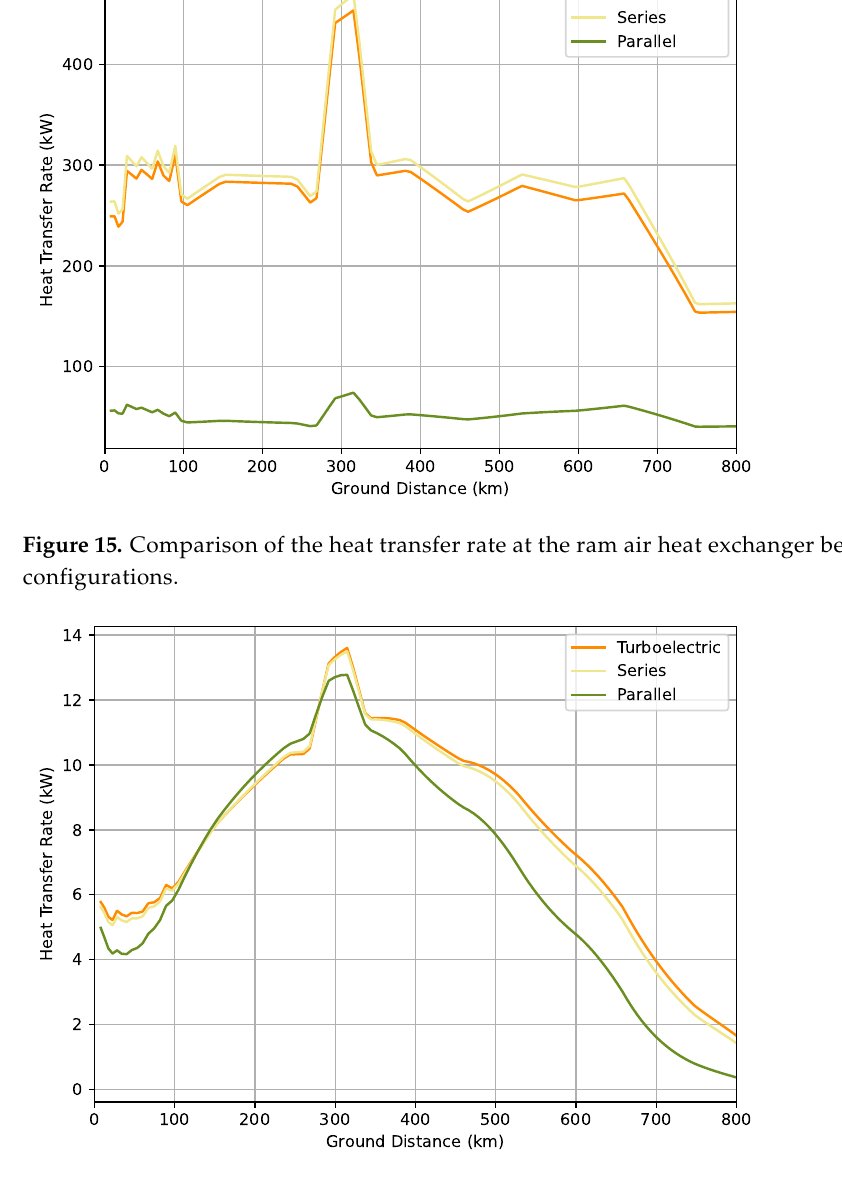
Figure 16. Comparison of the heat transfer rate at the fuel heat exchanger between the three